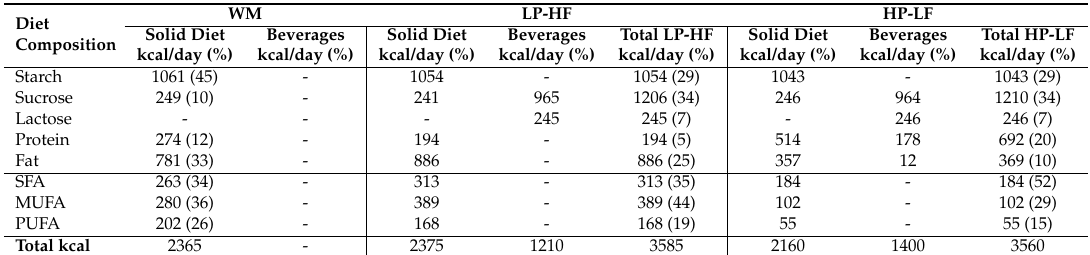
Table 1. Energy content and macronutrient composition of WM, LP-HF and HP-LF.